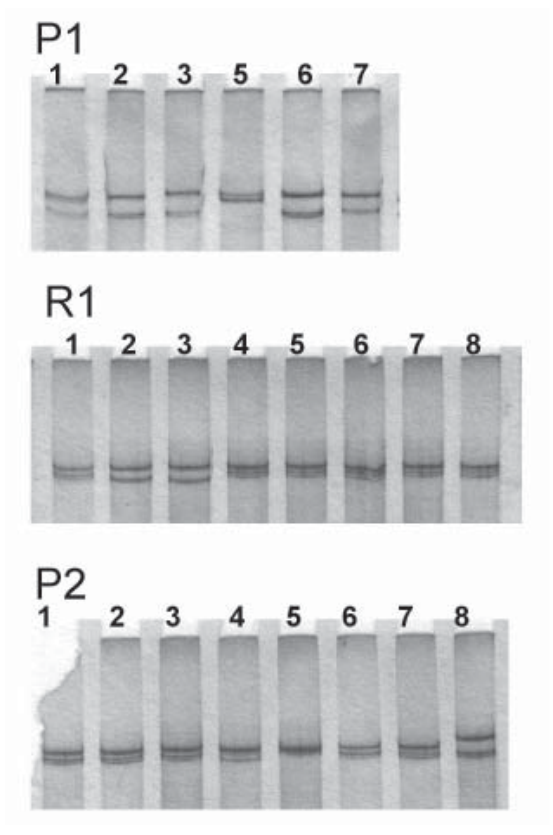
Fig. 2. Single-stranded conformation patterns of the cloned coat protein gene from isolates P1, P2 and R1. The lane number indicates the